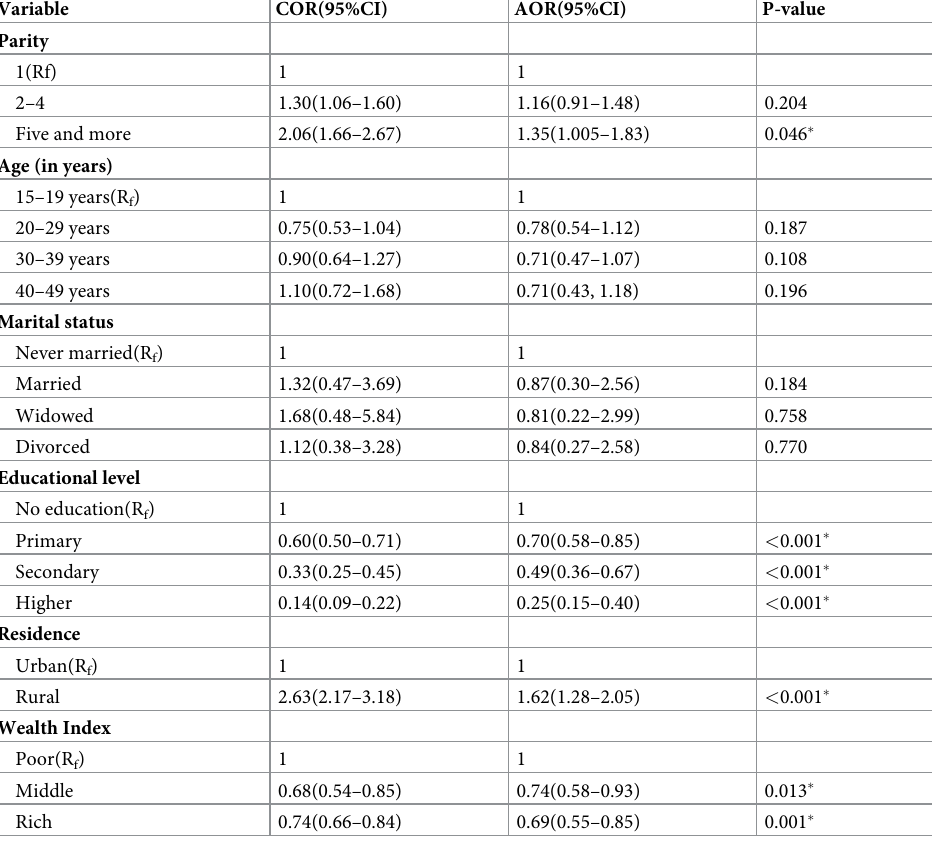
Table 4. Multivariable logistic regression analysis of factors associated with late ANC booking among women in Ethiopia,